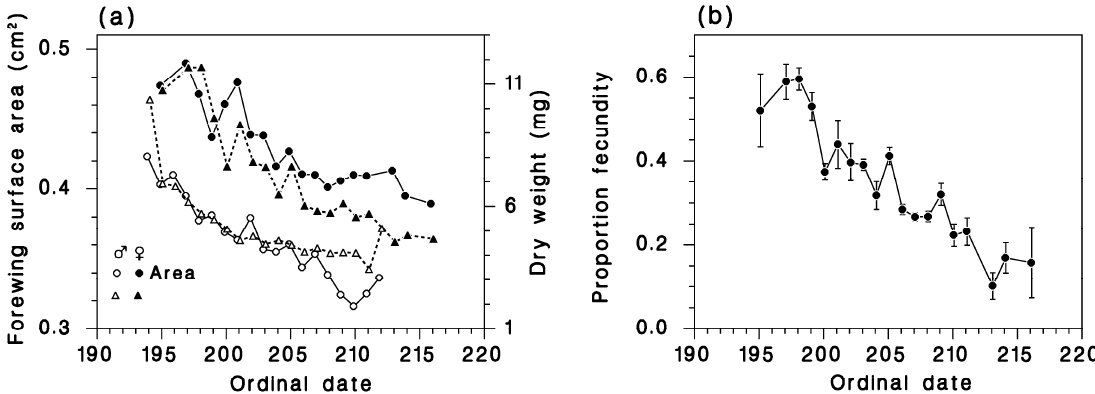
Figure 4. ( a ) Changes in average forewing surface area and dry weight over the flight season in males and females. ( b ) Gravidity of females calculated with Equation (5) (vertical bars represent the